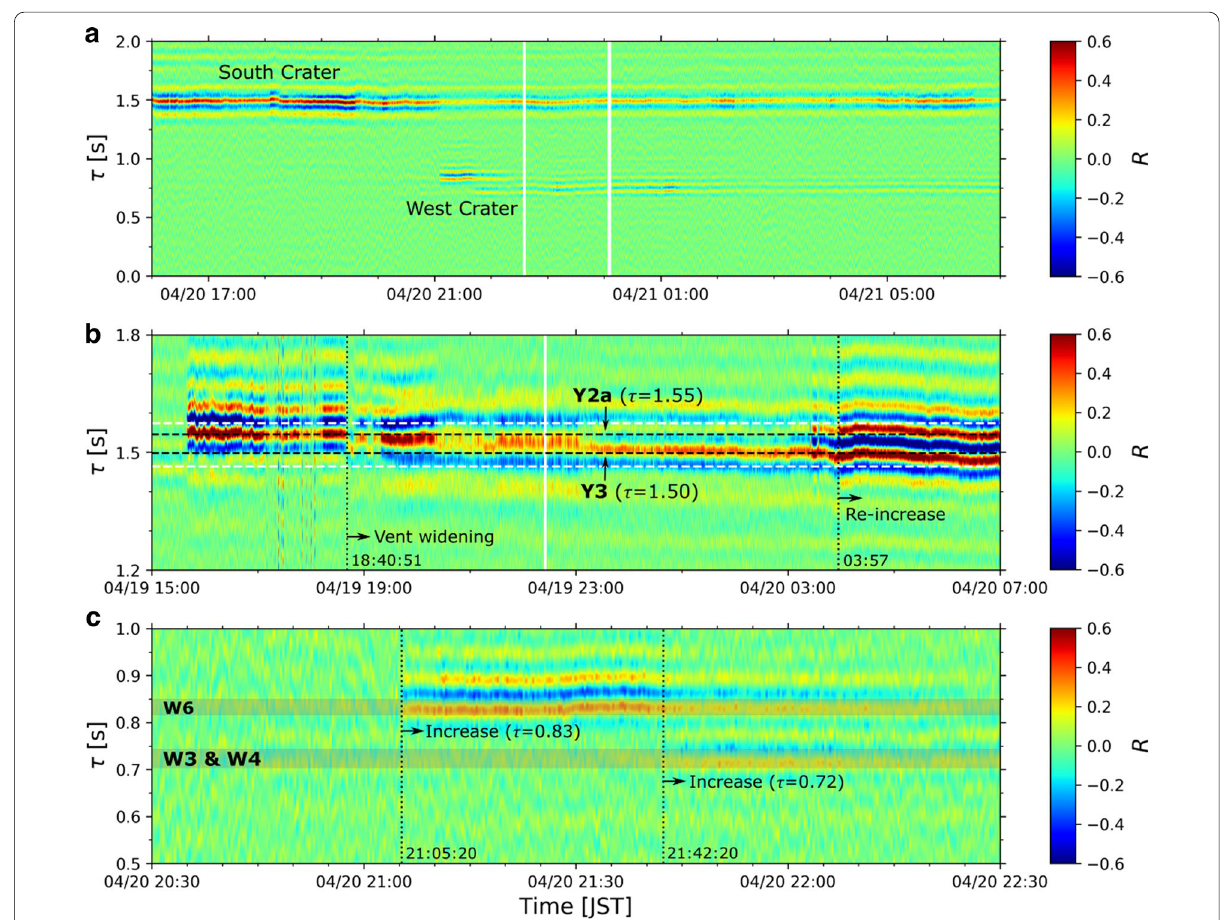
Fig. 4 Stacked cross-correlation coefficients for the higher-frequency band. a The t − τ plot of the stacked cross-correlation coefficients in the frequency range of 7–20 Hz from 16:00 on April 20 to 7:00 on April 21. The vertical white lines represent periods with missing data. b The plot focusing on the South Crater signals from 15:00 on April 19 to 7:00 on April 20. The expected lag time ranges of the South Crater (1.46–1.58 s) are bounded by the horizontal white dashed lines. The horizontal black dashed lines are τ = 1.55 s and 1.50 s, corresponding to Y2a and Y3, respectively. The vertical dotted lines mark times of the vent widening onset (18:40:51 on April 19) and emergence of the high-frequency signal power (3:57:00, on April 20). c Enlarged view of the t − τ plot from 20:30 to 22:30 on April 20. Gray shaded regions indicate the expected lag times of the vents W3– W4 and W6. The clear signals appear at 21:05:20 from W6 and at 21:42:20 from W3–W4 (vertical dotted